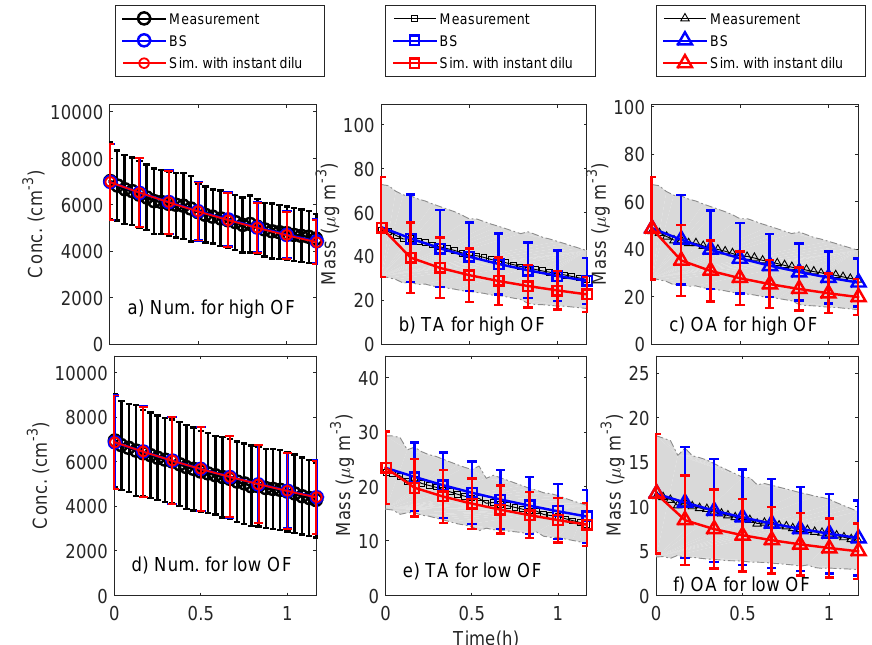
Figure 12. Similar to Fig. 2 but for the simulation with instantaneous dilution by 25:1.